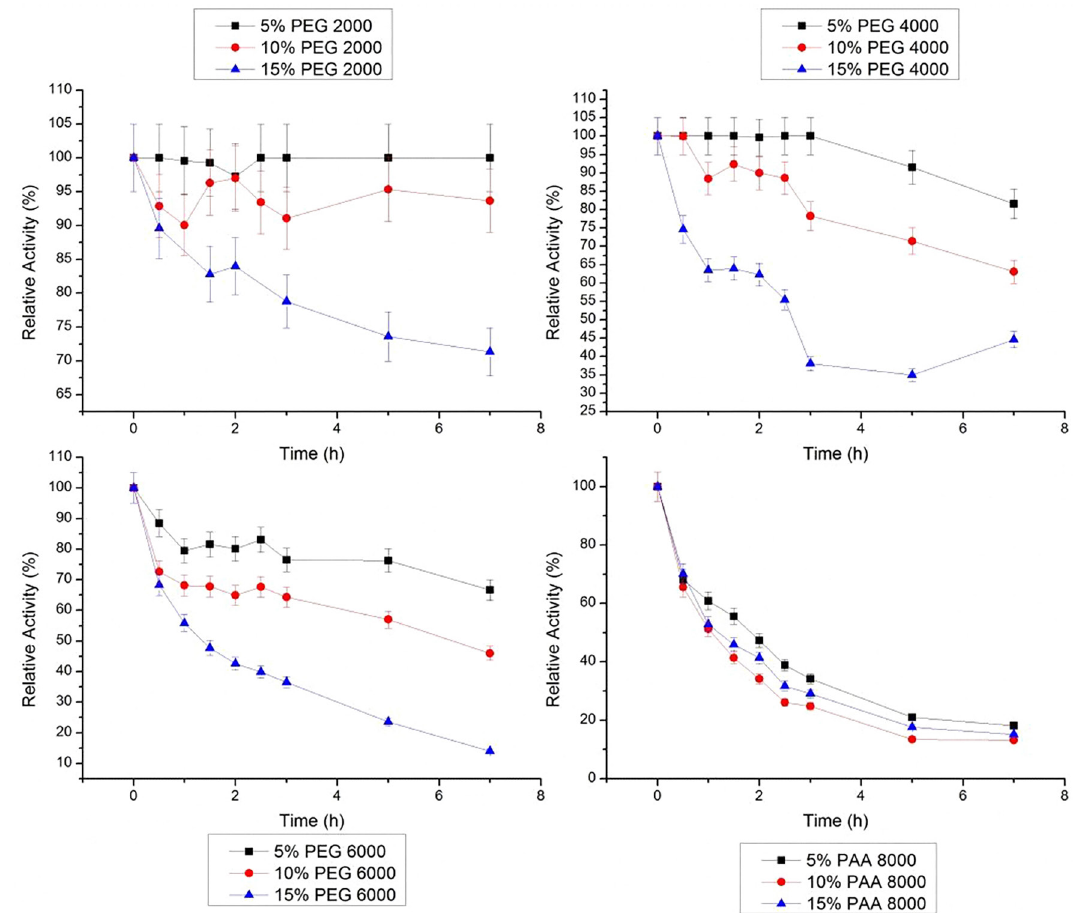
FIGURE 8 - Relative stability of bromelain at 50 ºC in PEG 2000, 4000, 6000g/mol and PAA 8000 g/mol at three concentrations (5, 10 and 15% w/w). The error bars refer to standard TABLE II - Energy of activation (Ea), enthalpy (ΔH) and entropy (ΔS) of stem bromelain in the studied polymers.